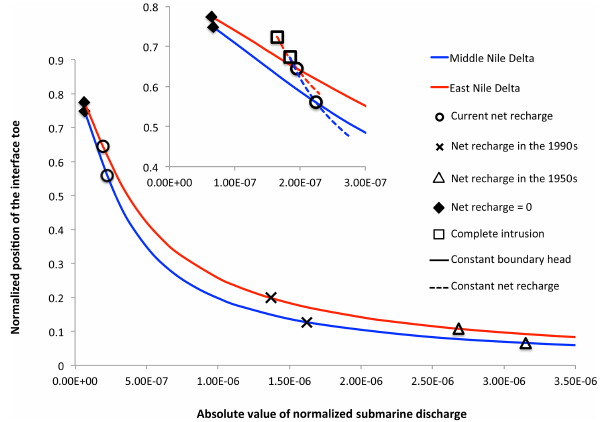
Fig. 4. Seawater intrusion performance curves for the middle and east Nile Delta aquifer cross sections. Symbols mark the calculated normalized intrusion toe position, l T / L , as a function of the nor- malized submarine groundwater discharge q SD /(KL) under constant boundary head conditions for present and past groundwater pump- ing and associated net recharge conditions (continuous lines in main graph and inset), for which the tipping point of full intrusion (open squares) cannot be reached. The inset shows comparative results (dashed lines) for variable head conditions at the boundary under constant net recharge conditions at current levels, for which the tip- ping point of full intrusion (open squares) can be reached.